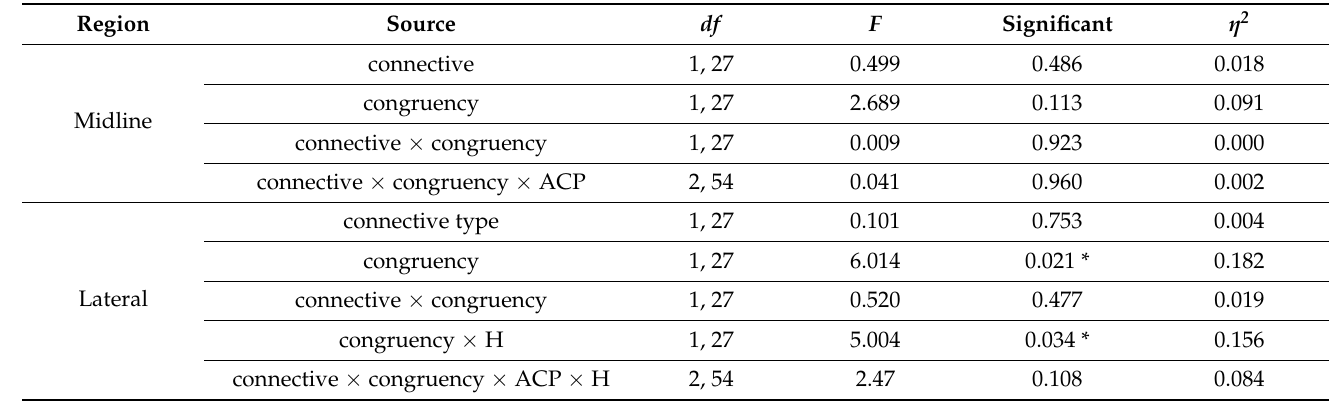
Table A2. The results of ANOVAs on mean amplitude at the sentence-final words in the 300–800 ms time